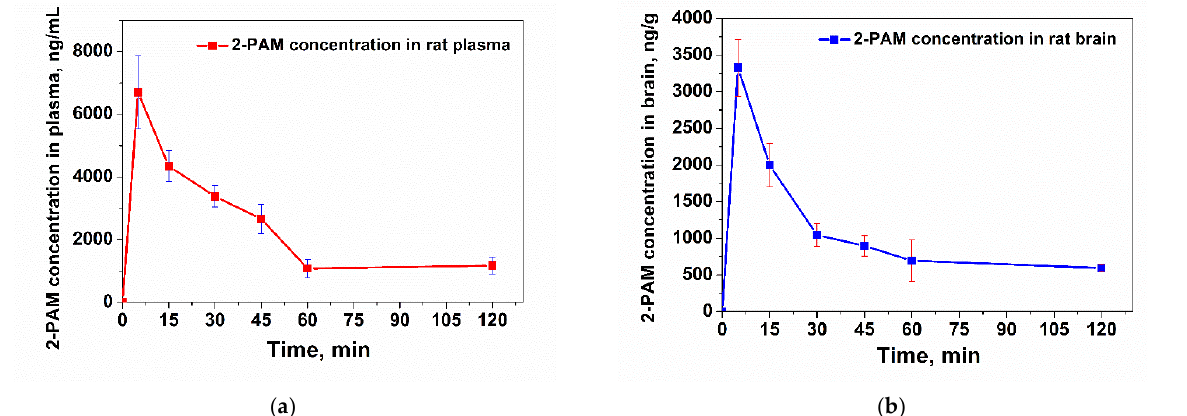
Figure 9. Concentration of 2-PAM in blood plasma ( a ) and brains ( b ) of rats after intravenous injection of 2-PAM in IA-16/PC liposomes (25 mg/kg), determined by HPLC-ESI-MS. Each point represents the mean ± standard deviation for five rats. Table 5. Protection of mice against POX toxicity.